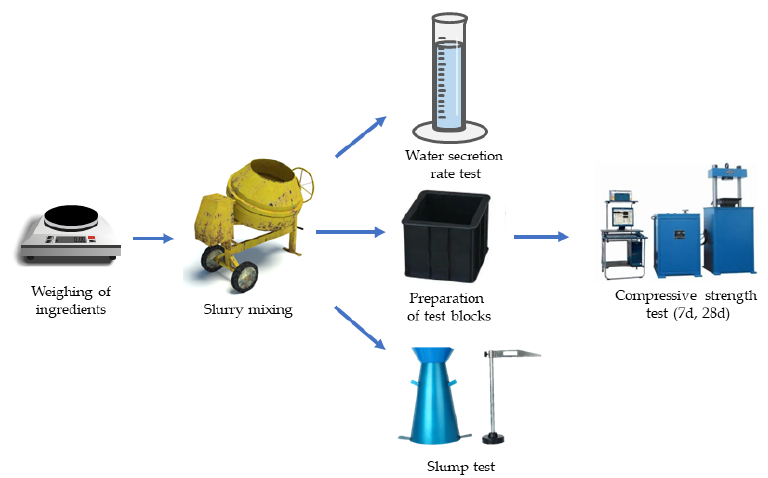
Figure 2. CFTFM performance testing technology roadmap.